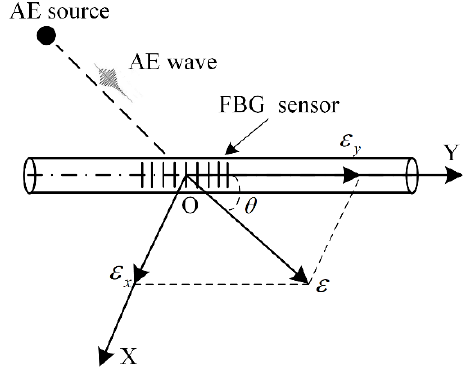
Figure 3. The coordinate system of the FBG sensor and the strain decomposition.